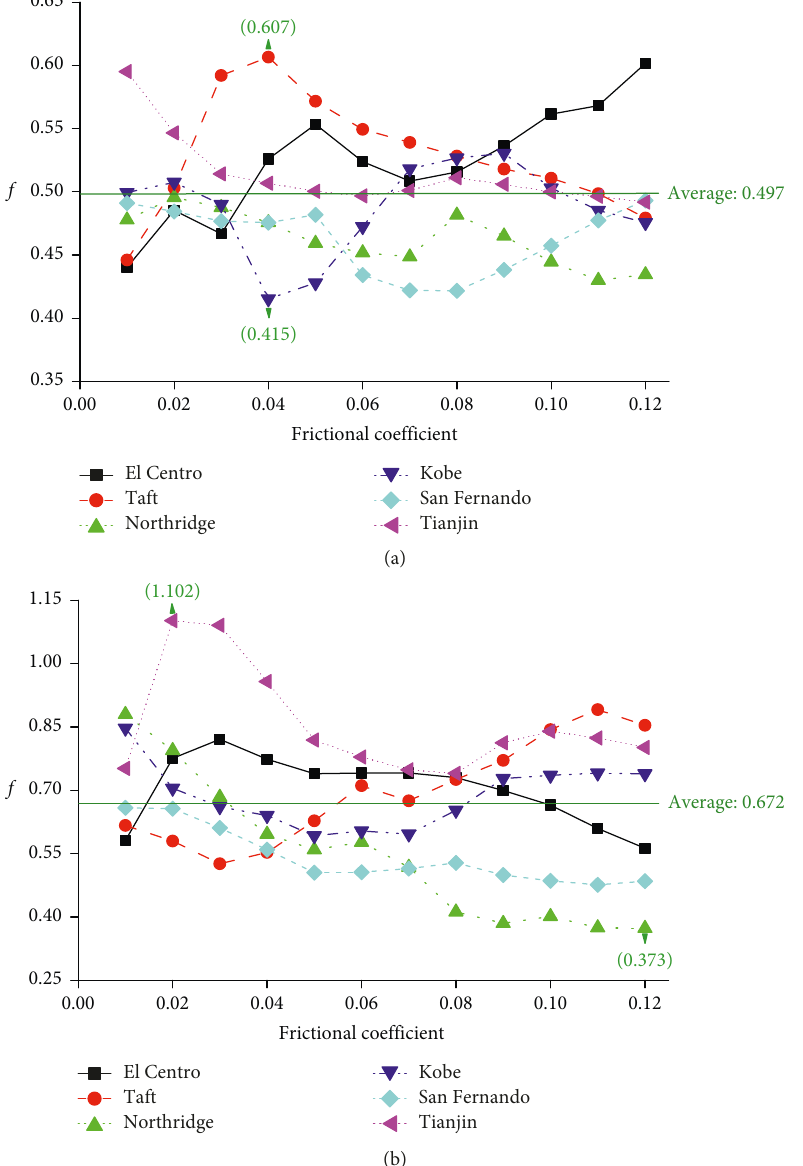
Figure 14: Comparison of the response amplitude of the pier top under various ground motions. (a) Displacement amplitude of the pier top. (b) Acceleration amplitude of the pier